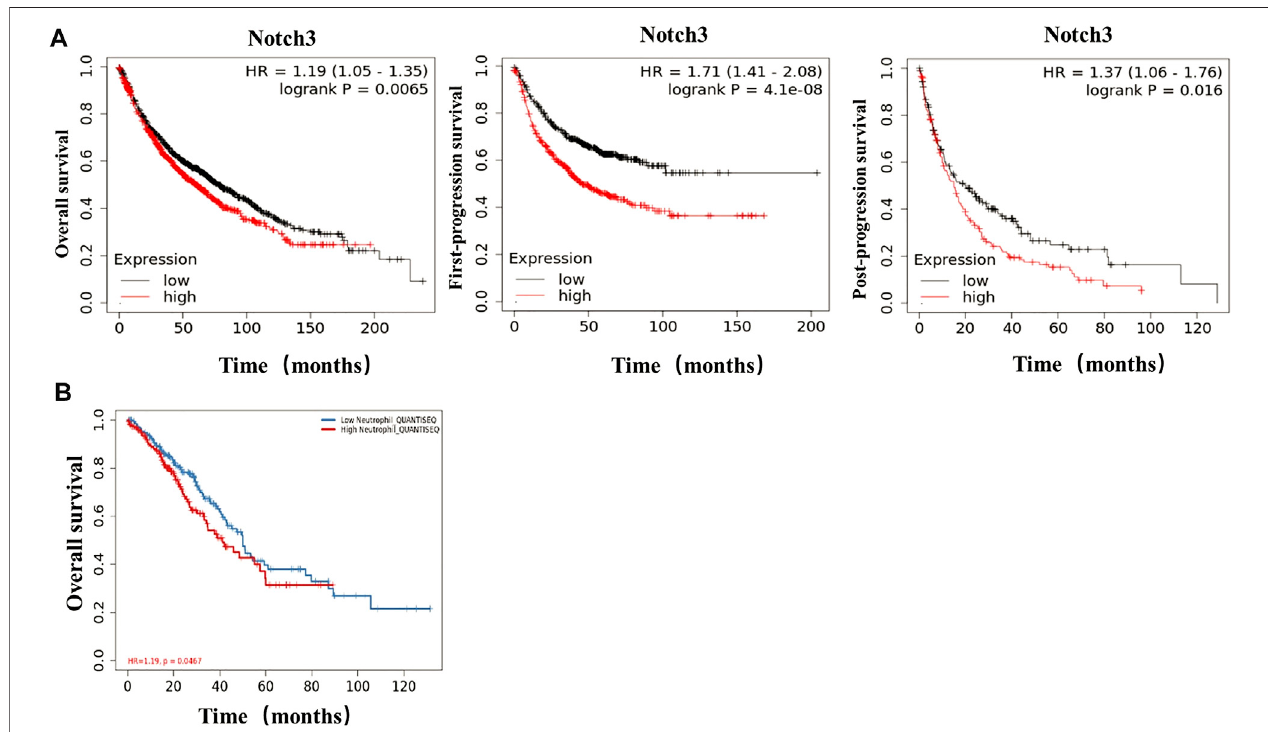
FIGURE 4 | In lung adenocarcinoma, TANs and Notch3 correlate with poor prognosis. (A) The correlation of Notch3 and OS, FPS, PPS in lung adenocarcinoma was analyzed by Bioinformatics data. (B) The correlation of TANs and OS in lung adenocarcinoma was analyzed by Bioinformatics data.